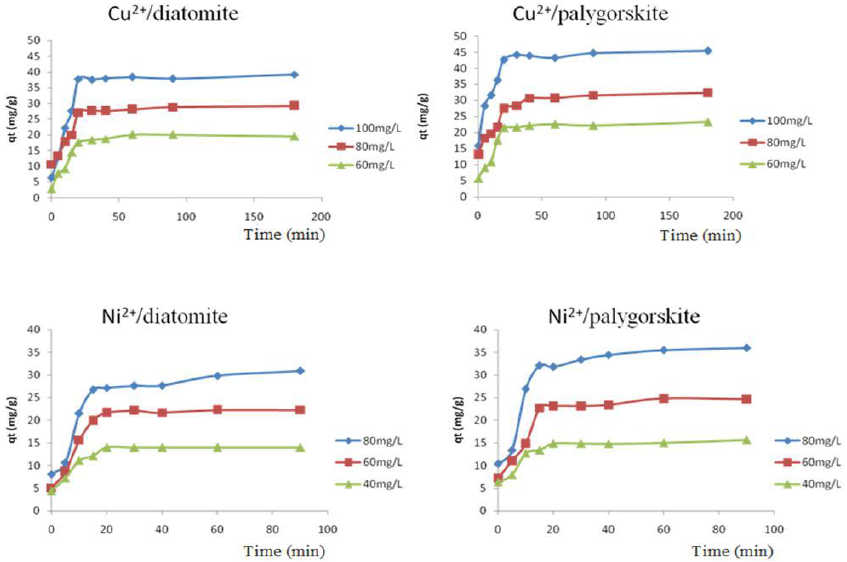
Figure 3. Effect of contact time on the adsorption of Cu(II) and Ni(II) on diatomite and palygorskite at different concentration (m adsorbent = 0.5 g, v = 300 rpm, T = 25 °C, pH Cu2+ = 7, pH Ni2+ = 4).